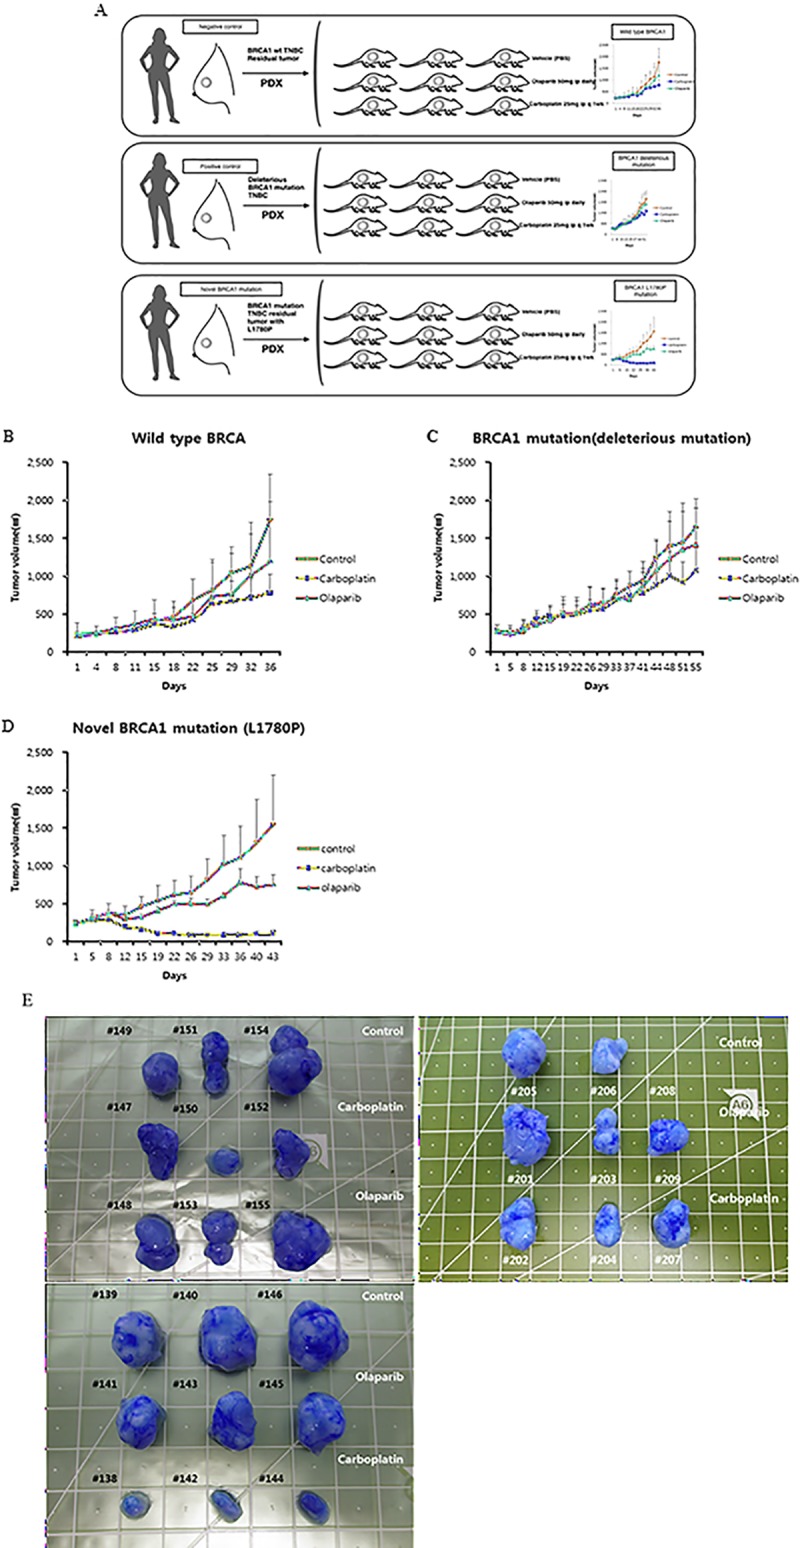
Scheme and results of chemosensitivity tests using PDX models.(A) PDX models were derived from patients who had BRCA1 mutation (n = 2) or wild-type BRCA1 (n = 1). Each model comprise nine mice, which were divided into three groups (1 group = 3 mouse, two single treatment groups and one vehicle group). (B-E) When implanted tumor reached an average size of 200–250 mm3 (Volume = 0.5×Length×Width^2), the chemosensitivity test was performed. Olaparib (50mg/kg, once a daily) and carboplatin (25mg/kg, once a weekly) were administered by an intra-peritoneal (i.p.) route. Phosphate buffered saline was used to as a vehicle.